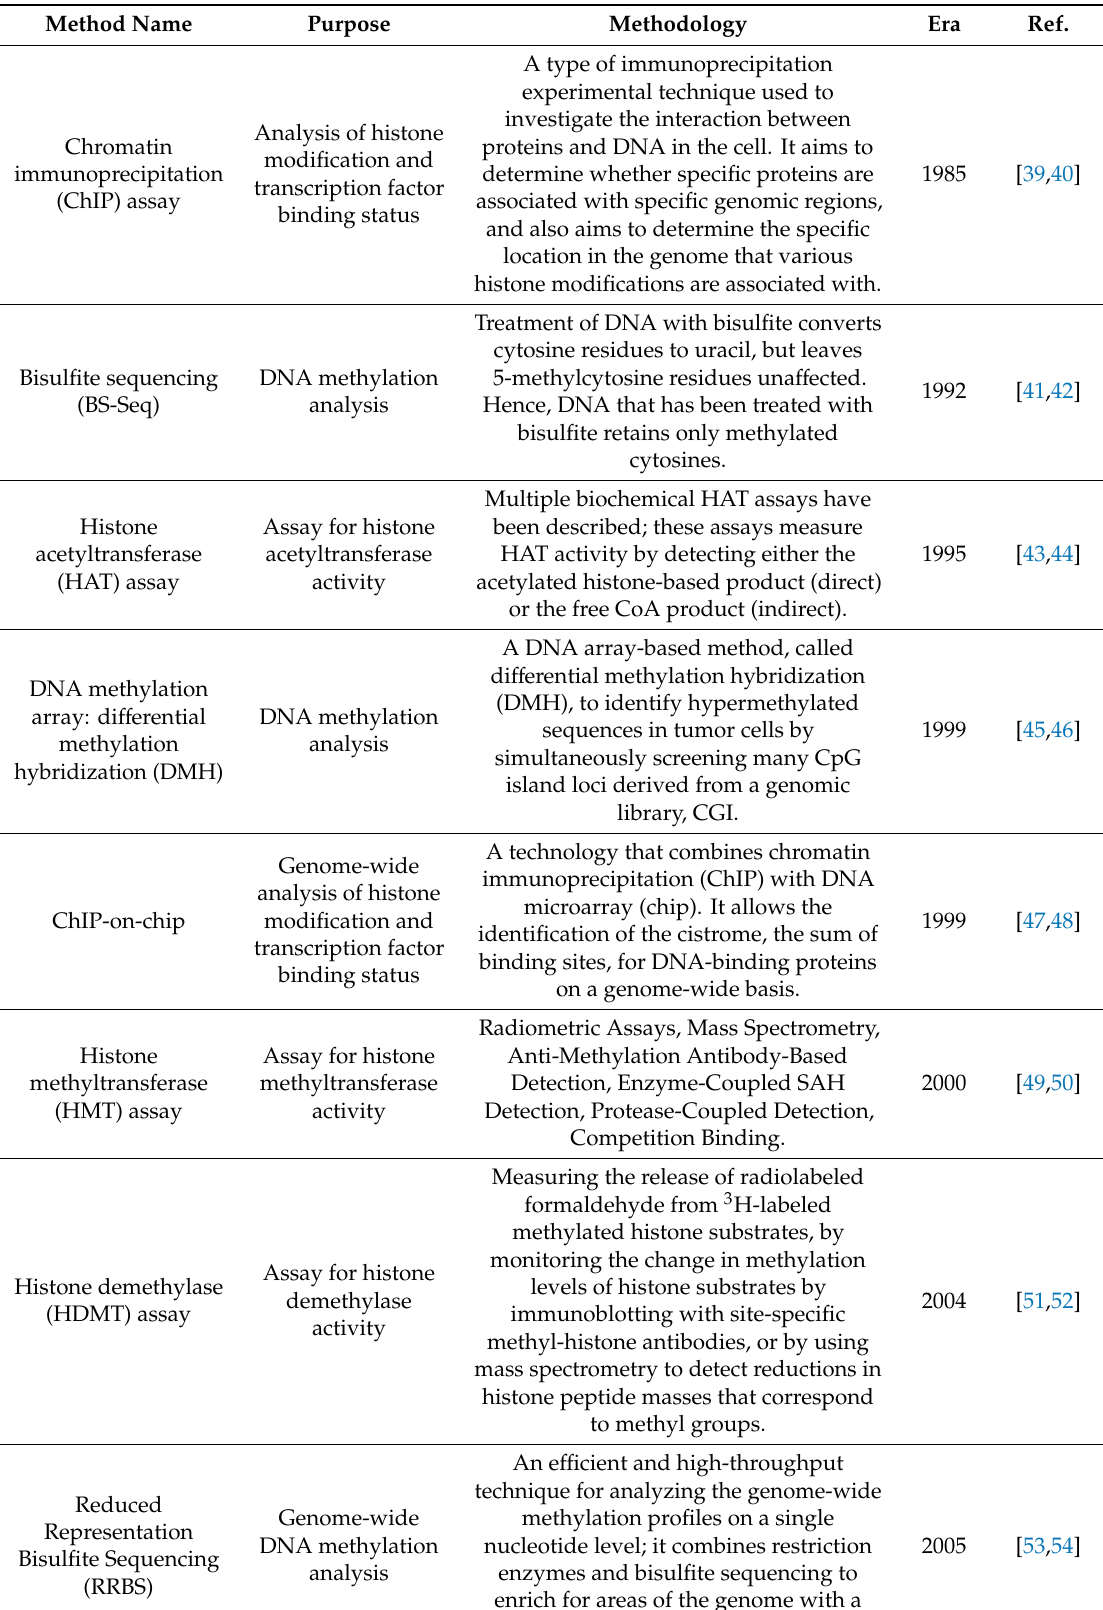
Table 1. List of main technologies for epigenetics and chromatin